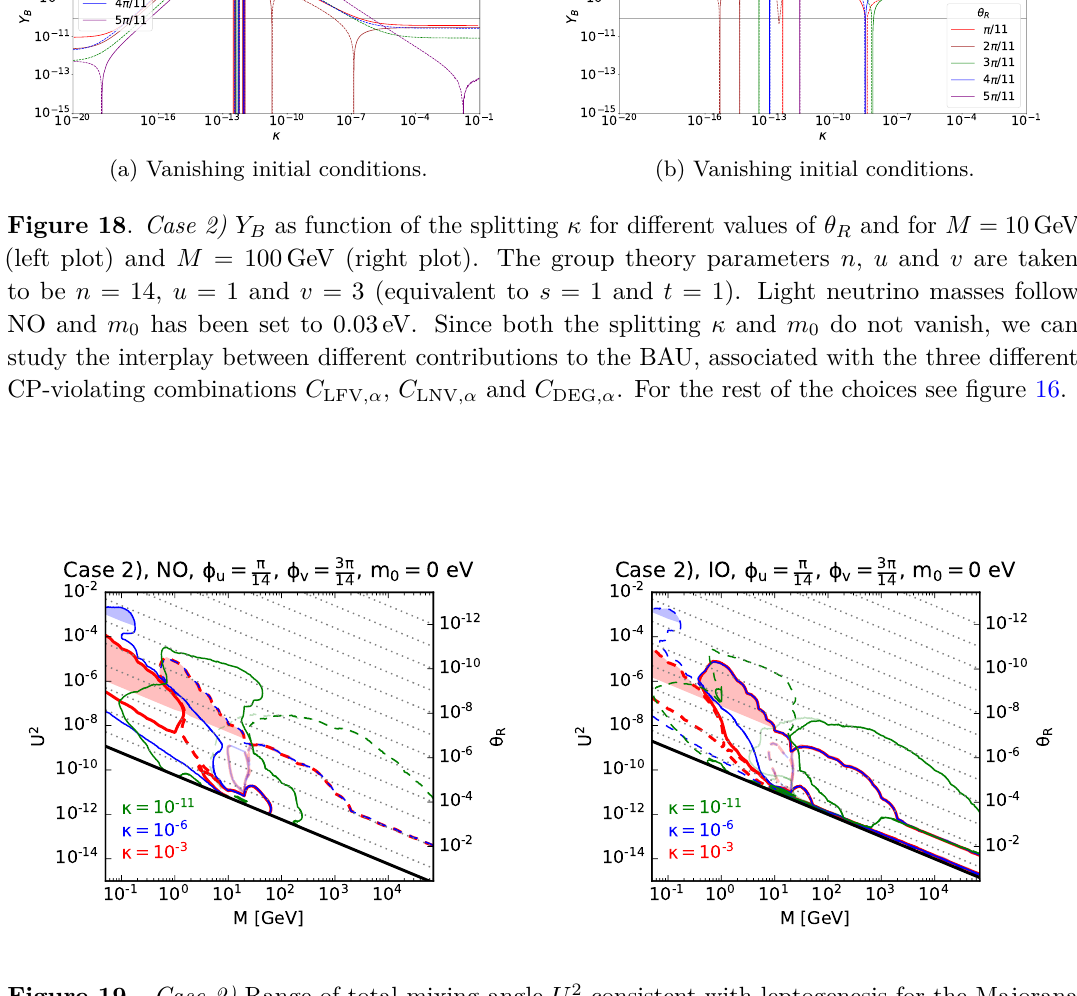
Figure 19 . Case 2) Range of total mixing angle U 2 consistent with leptogenesis for the Majorana mass M varying between 50 MeV and 70 TeV. The splitting κ is chosen among the three values κ ∈ { 10 − 3 , 10 − 6 , 10 − 11 } . The angle θ R can be read off. The values of φ u and φ v are fixed to φ u = π 14 and φ = 3 π corresponding to t odd. Light neutrino masses follow strong NO (left plot) and strong v 14 IO (right plot), respectively. The contours corresponding to positive (negative) value of the BAU are shown in continuous (dashed) lines. Note that these refer to vanishing initial conditions except for the lines shown in fainter colours. For masses larger than M ∼ 10 GeV, we see that the lines for κ = 10 − 6 and κ = 10 − 3 coincide. This can be verified in figure 16, where Y B becomes independent of the splitting κ for κ & 10 − 6 . In contrast, for κ = 10 − 11 both Y and the allowed total mixing B angle U 2 are generically larger for larger masses M . The blue and red shaded areas show the regions in which a condition like the one in eq. (3.69) is not fulfilled. The black lines indicate the seesaw line. Note the striking similarity between these results and those obtained in Case 1), see figure